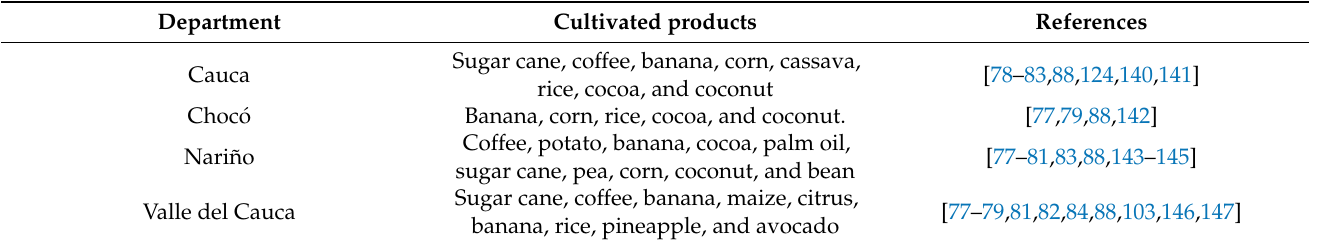
Table 13. Pacific region.